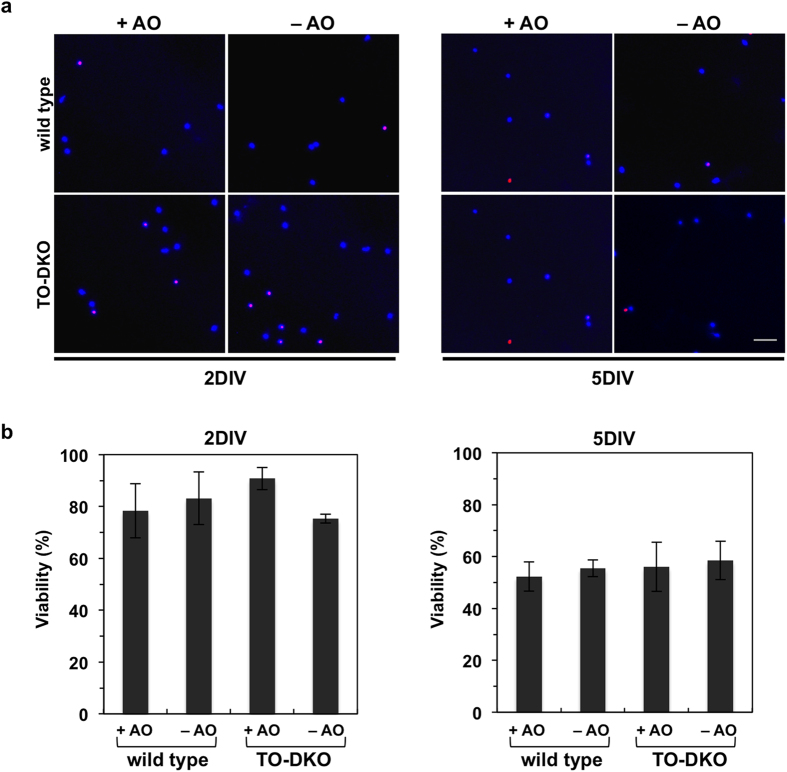
Mth1/Ogg1-DKO neurons do not exhibit increased cell death in the absence of antioxidants.(a) Adult cortical neurons isolated from adult Mth1/Ogg1-DKO (TO-DKO) and wild-type mice were cultured for 2 days in vitro (2DIV, left panels) and 5 days in vitro (5DIV, right panels) in the absence (−AO) or presence (+AO) of antioxidants in the B27 supplements, and were subjected to Hoechst 33258 (blue, nuclear staining) and propidium iodide (PI, red, dead cells) staining. Representative images are shown. (b) Viability. The percentage of PI-negative cells among Hoechst 33258-positive cells was determined. 2DIV (left, 2-way ANOVA, F(3, 16) = 0.7804, p = 0.522), and 5DIV (right, 2-way ANOVA, F(3, 16) = 0.1565, p = 0.924). Error bar = SEM. More than 11 cells in a given field were counted and five different fields per group (>79 cells/group) were examined. Scale bar = 40 μm.